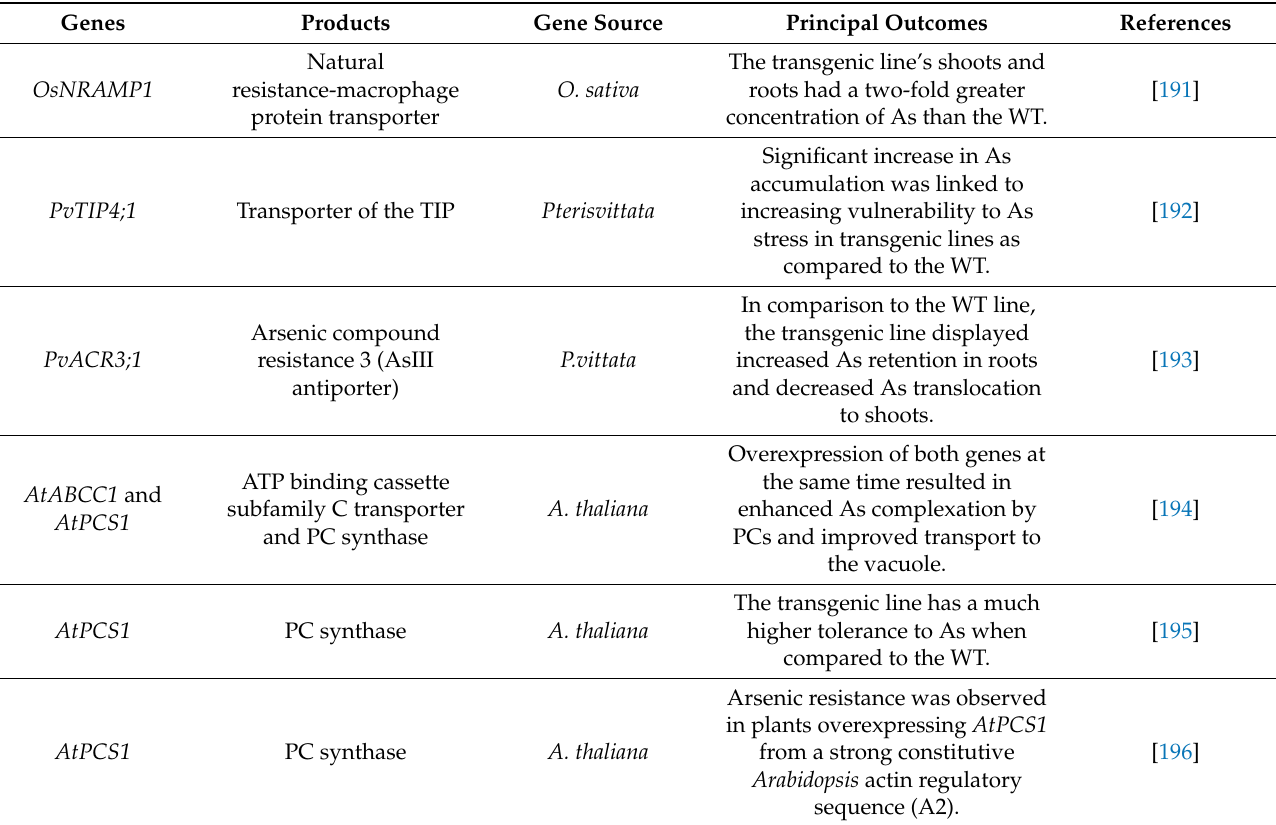
Table 3. List of plants with altered As tolerance acquired either by expression of foreign genes or through overexpression of wild type